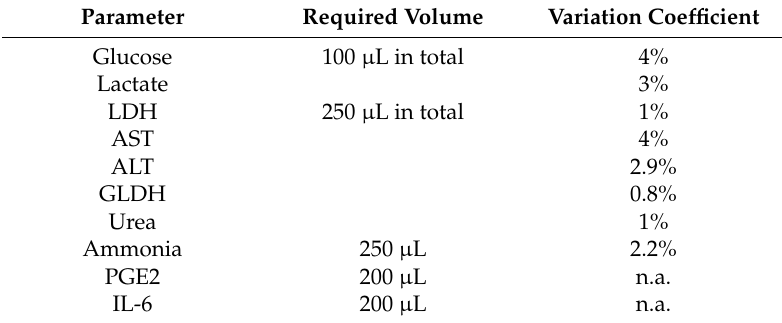
Table 2. Sample volumes and variation coefficients of analyzed clinical chemistry